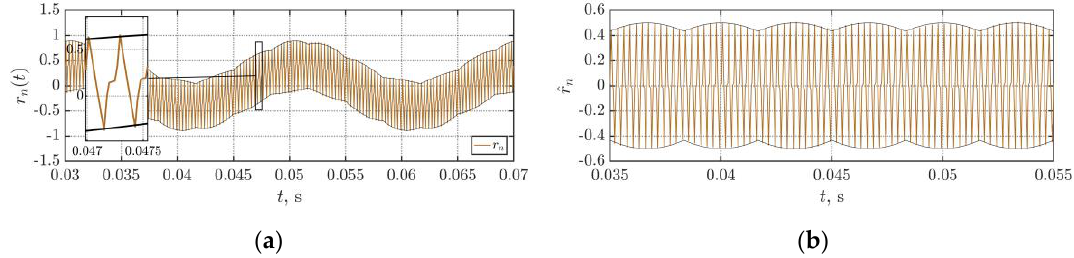
Figure 29. Profile and primary (black) envelope in case of m = 0.5 and f sw = 3.6 kHz: ( a ) Normalized neutral current; ( b ) Normalized neutral current ripple.